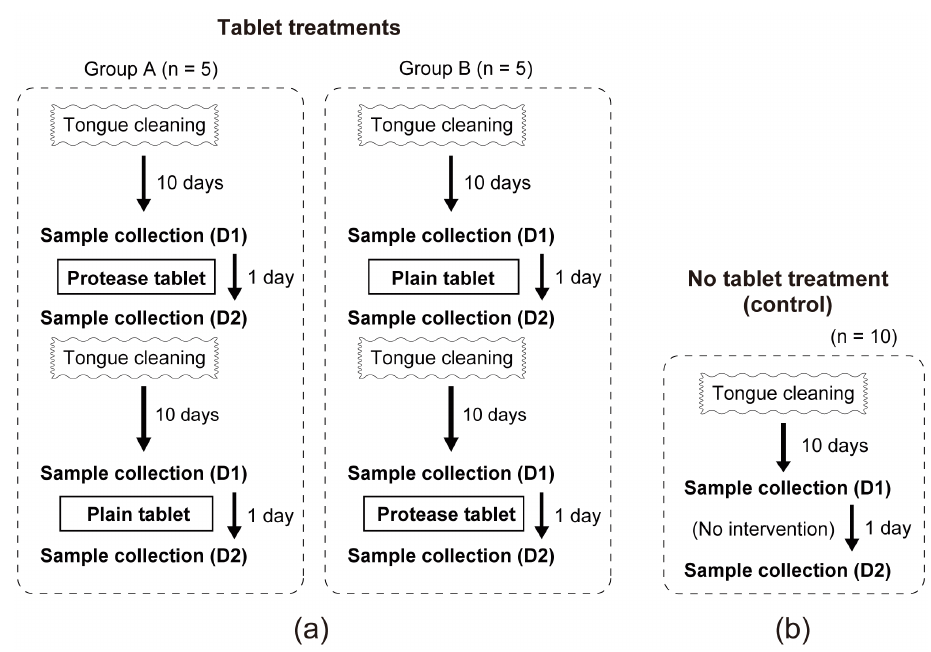
Figure 1. Schematic representation of the study design and trial schedule. ( a ) Ten participants were randomly divided into two groups for the tongue tablet trials. ( b ) Control (no tablet usage) treatment. The duration between the tablet treatments and the control experiment ranged from 10–60